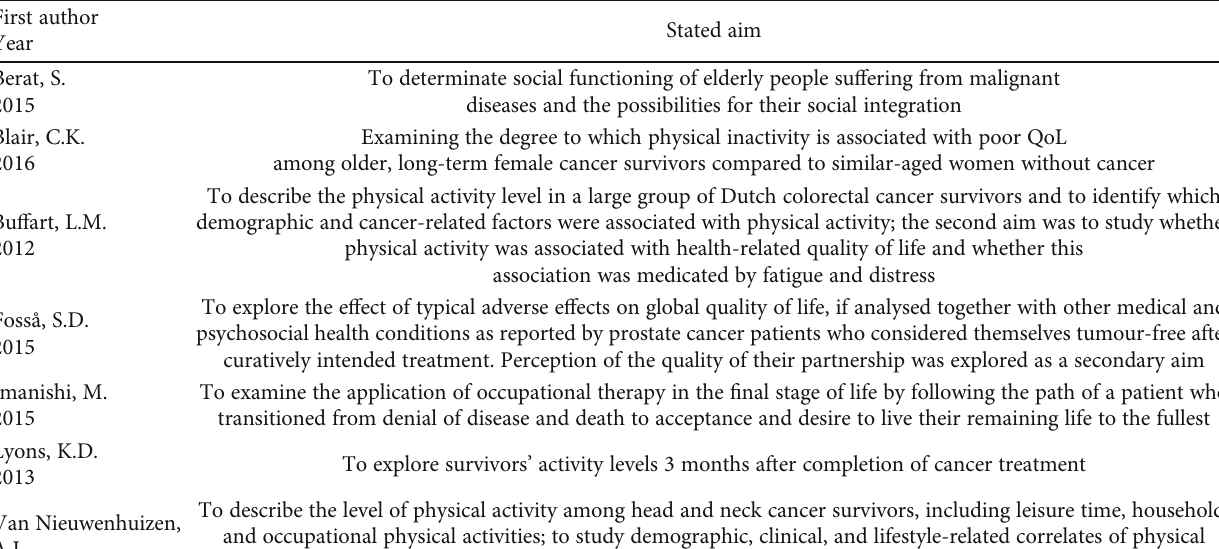
Figure 1: PRISMA fl ow diagram. ∗ PICOS: Participants, Interventions, Comparison, Outcomes, Study design. From Table 1: Stated aims of the included studies.